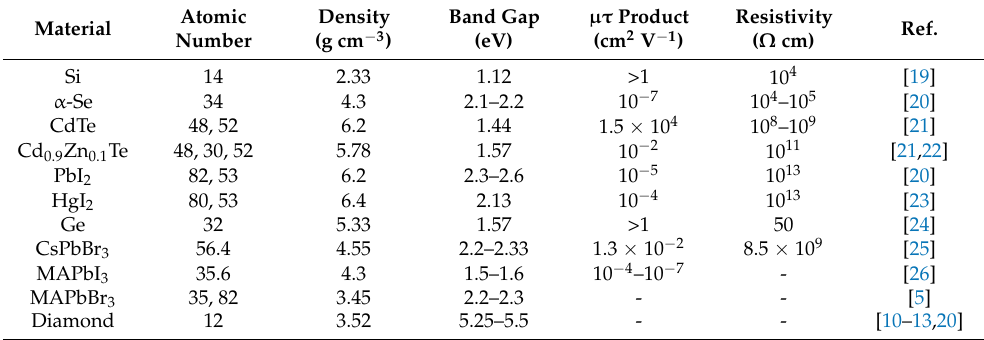
Table 1. The summarization of the parameters of the materials for X-ray detectors.